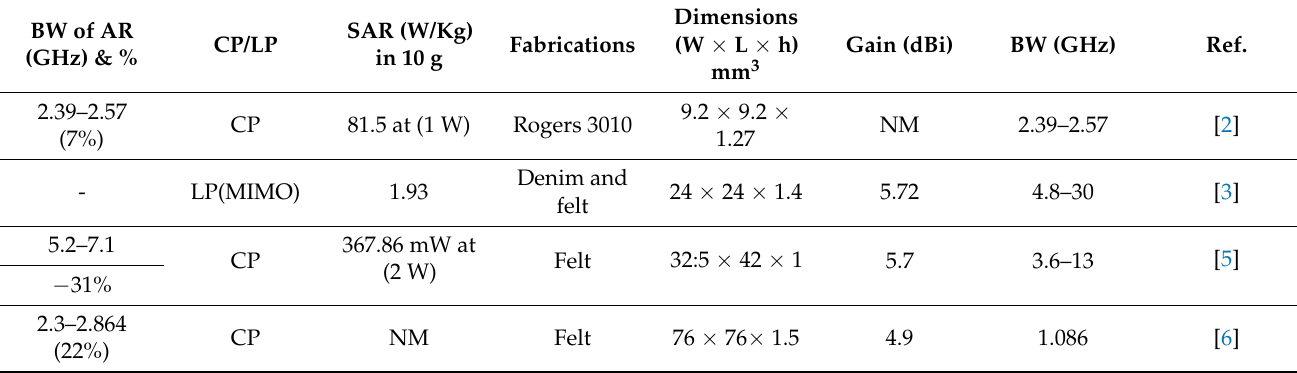
Table 3. Performance Comparison between proposed antenna sensor and previously reported